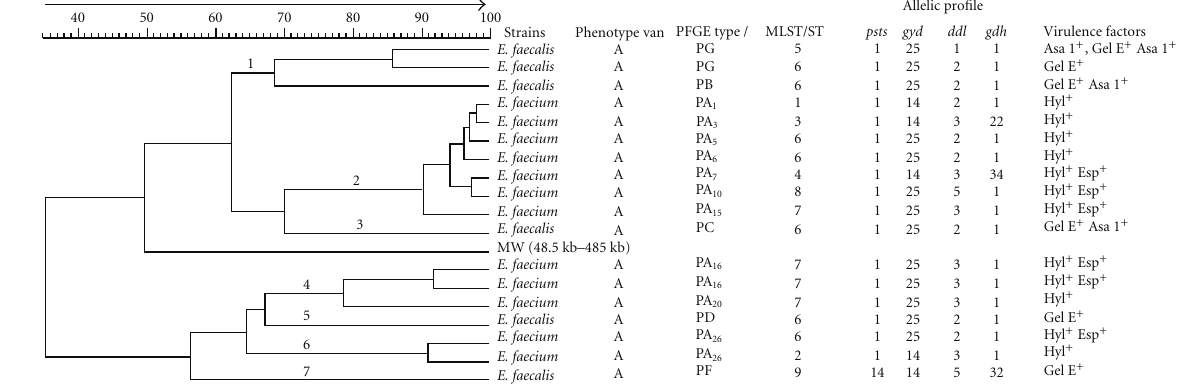
Figure 1: PFGE dendrogram with the corresponding MLST sequence types of the GRE isolates, digested with SmaI . Strains were clustered by the unweighted pair-group method with arithmetic mean (UPGMA). Each row represents a unique PFGE type with its unique PFGE pattern. The corresponding MLST sequence type (ST) is shown with the corresponding strains. Molecular weight: (MW). Bacteriophage λ -ladder is given in kbp (48.5kb–485.0 kb) ∗ PFGE type A (PA) isolates 3, 4, 6–8, 10–13–24, 27, 29–32, 34, 36, 37, 39–43, 45, 46, 49–53, 55–60, 63–101, 103–115, 117–138. (+):